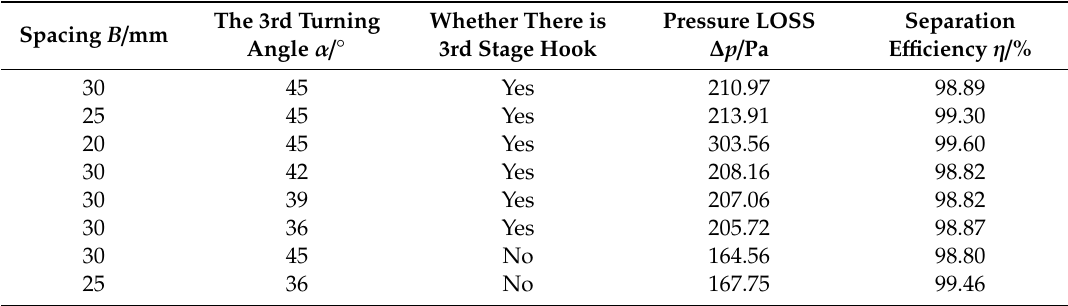
Table 3. Pressure loss and separation e ffi ciency under di ff erent structure